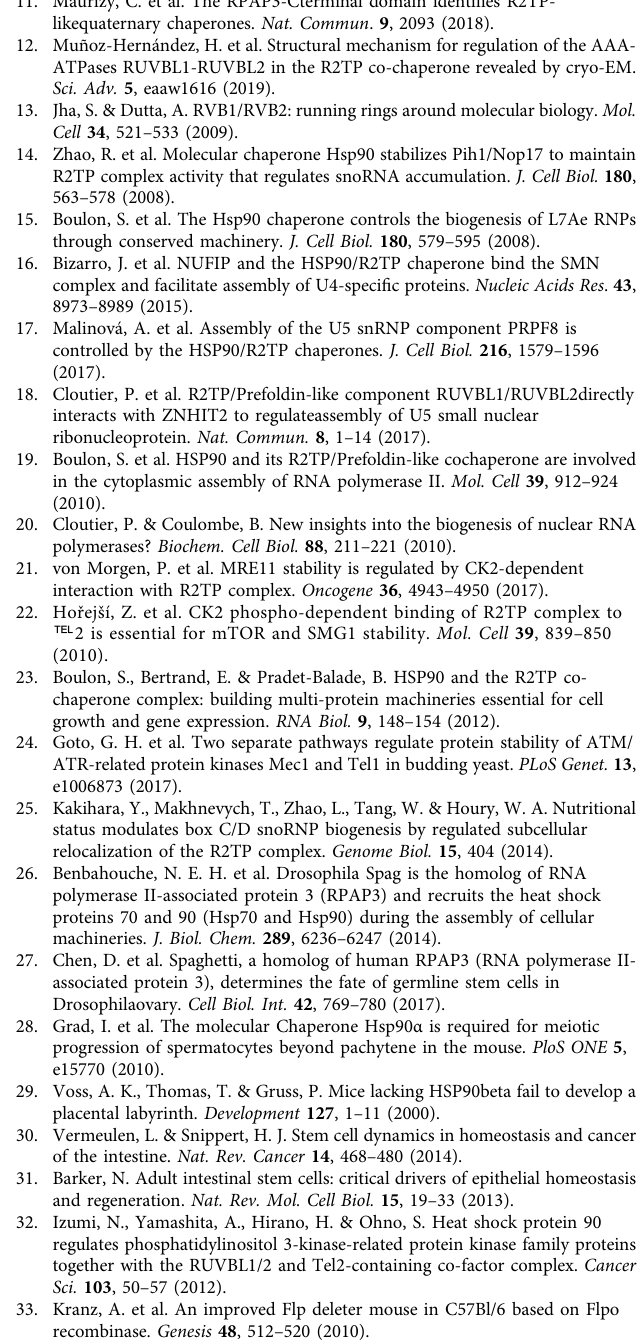
Fig. 9 R2TP expression correlates with pathological cell proliferation. a The graph depicts transcript levels of R2TP components in human primary colorectal tumor samples ( n = 380), as compared to normal solid tissues ( n = 51) from COADREAD cohort. y -axis: Log2 normalized counts for the indicated transcript. Distributions are presented as box-and-whisker plots (center line: median; box limits, fi rst and third quartiles; whiskers, 10th and 90th percentiles). Statistical signi fi cance was determined by one-way ANOVA (* p < 0.001). b Kaplan – Meier analysis of disease-free survival among 177 CRC patients according to the proportion of RPAP3-expressing cells in tumor tissues. Solid green line and dashed blue line indicate high and low proportion of RPAP3-expressing tumoral cells, respectively. Statistical signi fi cance was determined by log-rank test ( P = 0.037). Right panels show examples of CRC tissues with low (top) or high (bottom) RPAP3 expression, with scale bar. c Proposed model for R2TP activity in the small and large intestine. R2TP assembles cellular machineries such as RNA polymerases, snoRNPs, snRNPs, and PIKKs-complexes in CBCs and progenitors in the proliferative compartment (blue cells). Differentiated cells (including Paneth cells from the small intestine crypts, in pink) mostly rely on the complexes assembled during the proliferative phase. A defect in R2TP activity induces client dysfunction, cell cycle arrest and apoptosis via p53, and eventually,